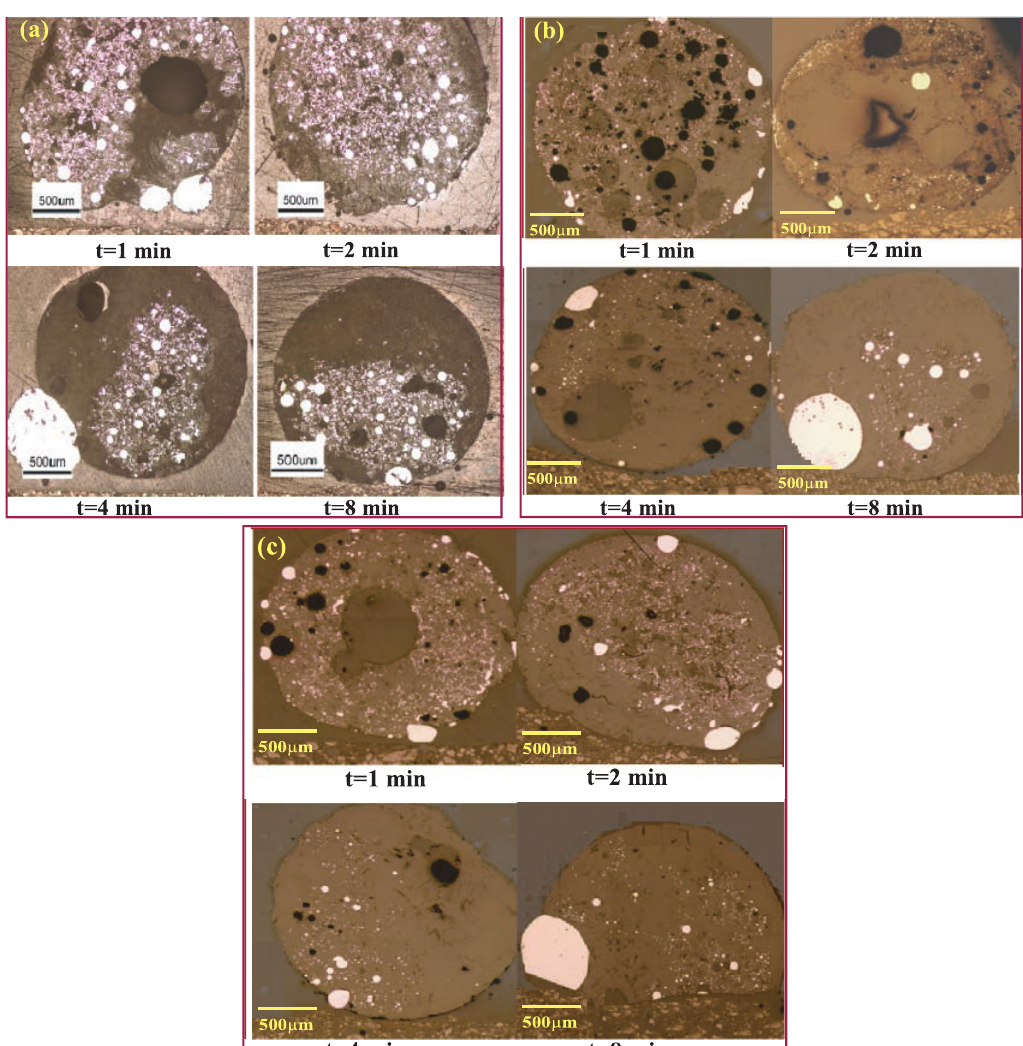
Fig. 6: Optical microscopy results on quenched Rubber (Blend 2 and Blend 3)-coke blends/slag and at 1550 °C. Bright regions represent reduced iron droplets; trapped gas bubbles are represented by dark spots